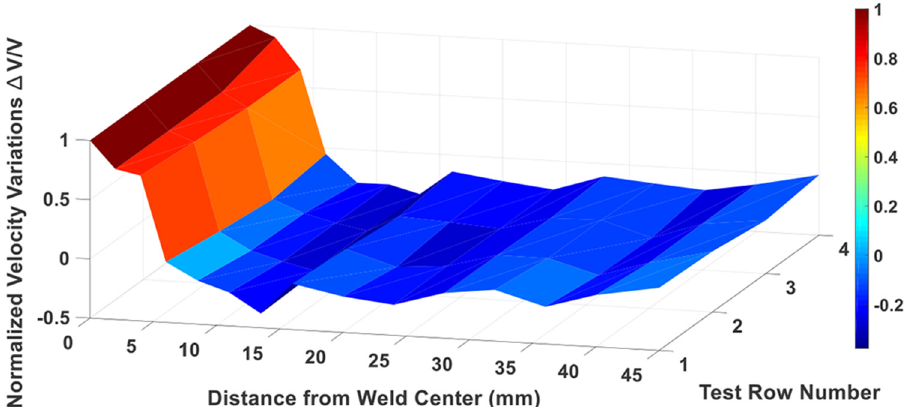
Fig. 14. Distribution of longitudinal residual stress on welded sample from ToF